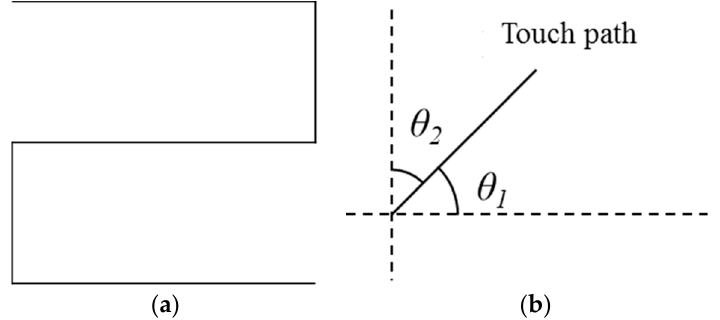
Figure 16. Measuring performance of proposed touch path filtering: ( a ) shape for measuring performance of path correction; ( b ) method for measuring touch path error.